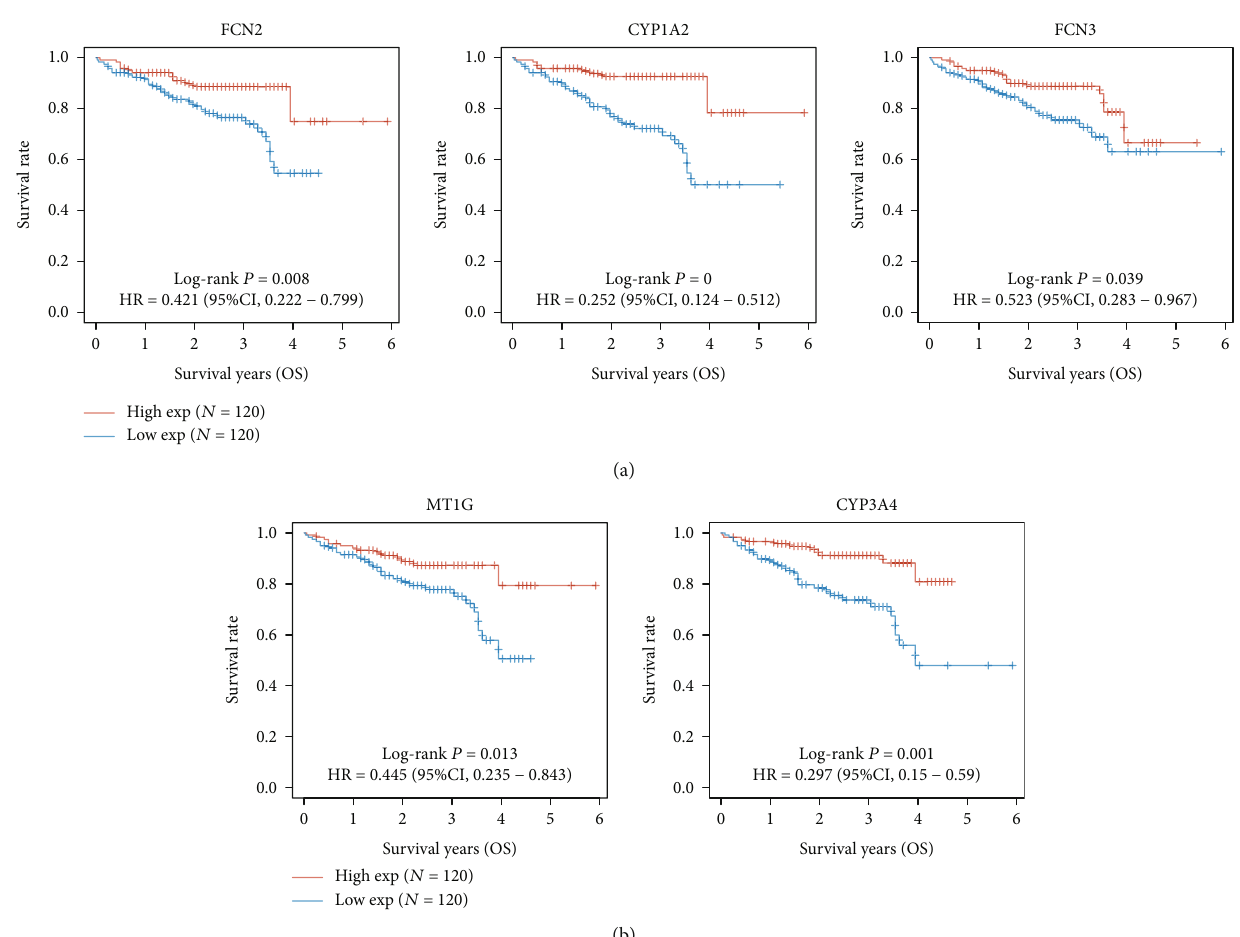
Figure 8: The prognosis value of the top 10 reduced genes in HCC from ICGC datasets. (a, b) FCN2, CYP1A2, FCN3, MT1G, and CYP3A4 were identi fi ed as OS-related